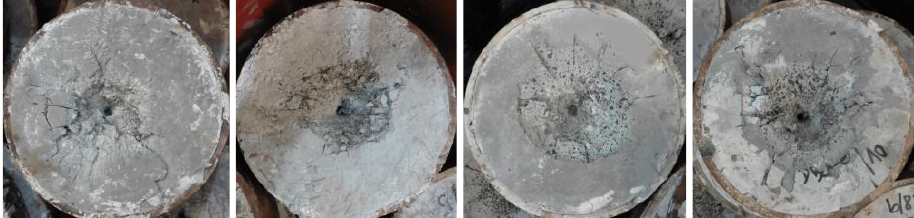
Fig. 4 Front surface of the targets after projectile penetration test; from the left C4, C8, B4,